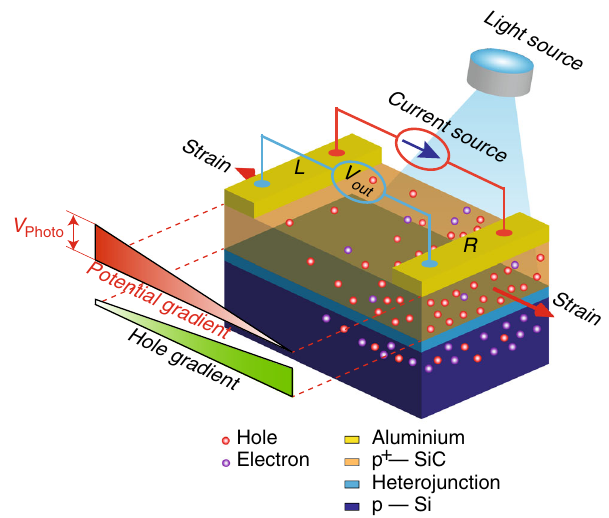
Fig. 1 The sensitivity enhancement by optoelectronic coupling. The piezoresistive effect in the cubic silicon carbide/silicon heterojunction was modulated by non-uniform visible light illumination on the surface of the sensing element coupled with an optimally controlled tuning